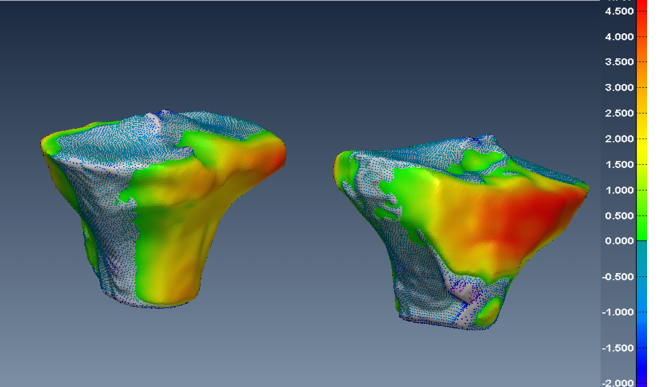
Figure 15. Two views of the colour-coded signed distance in mm between the U-Net 3D mesh and the SKI10 3D mesh for the tibia.